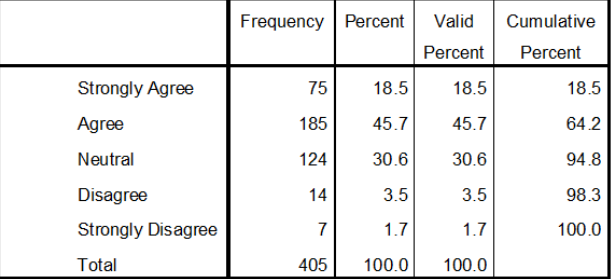
Fig 51. Our clients understand and stay patient in cases of minor issues and bottlenecks in terms of the performance of our cloud or IoT based products